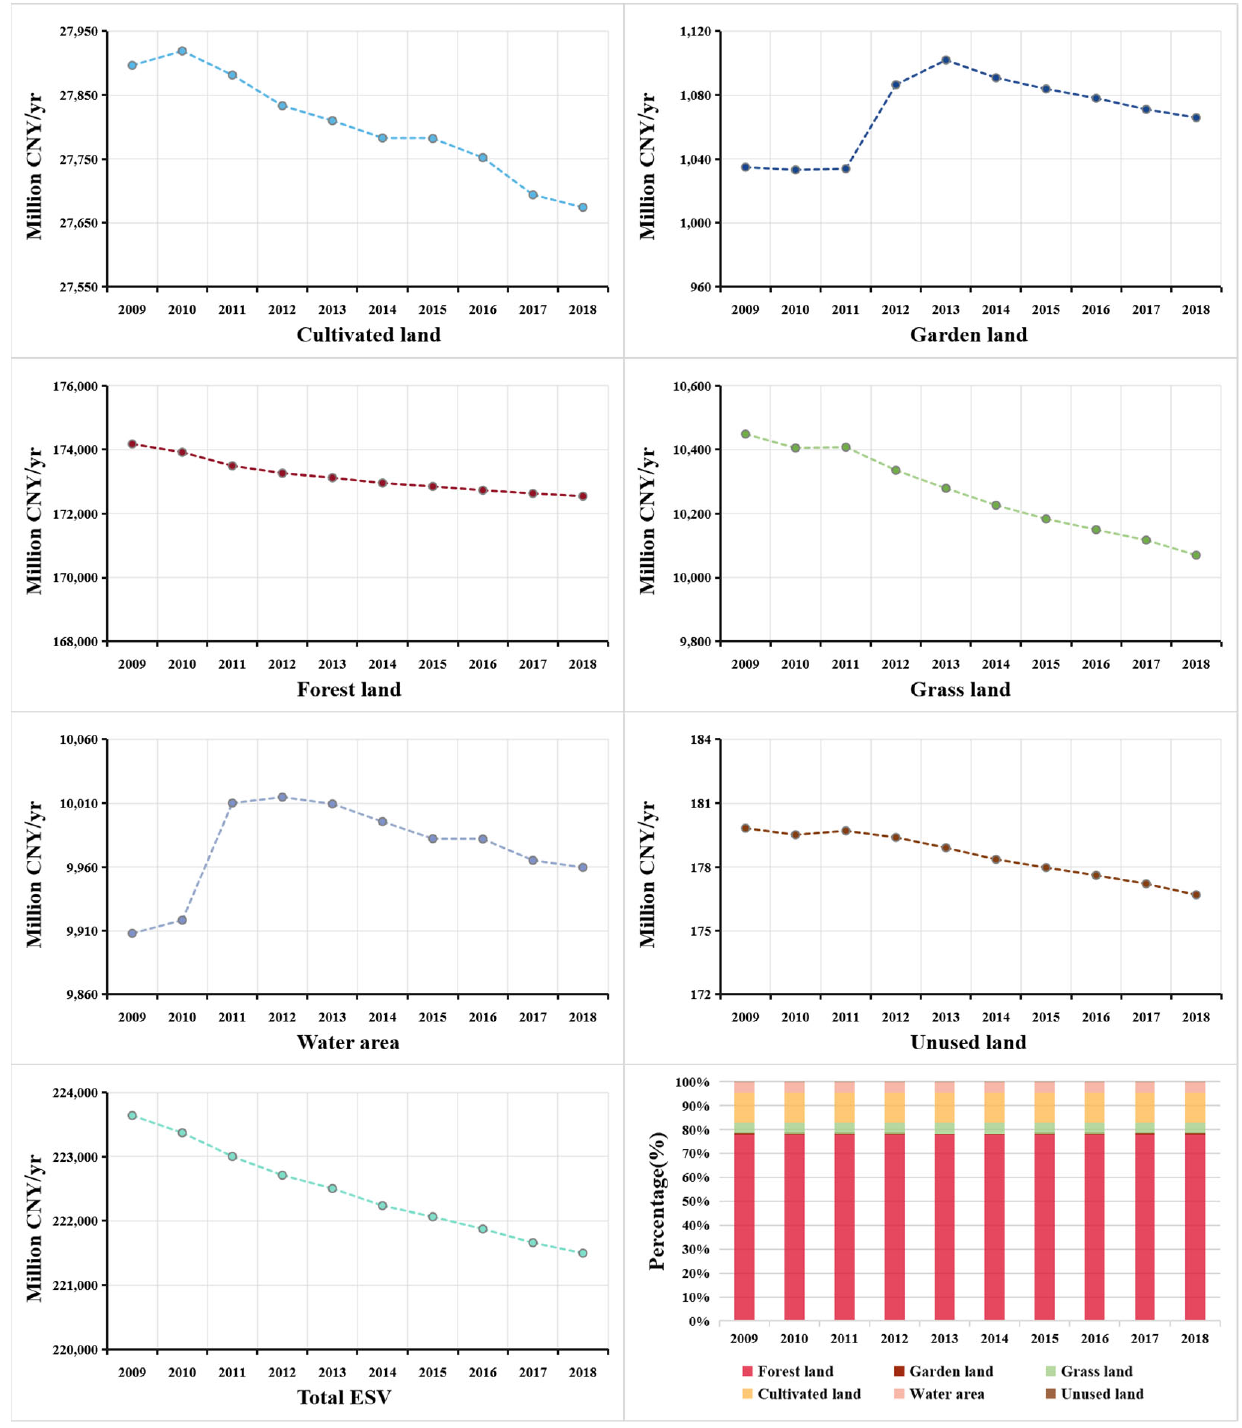
Figure 3. Change of ecosystem services value of different land use types in Guizhou Province from 2009 to 2018.